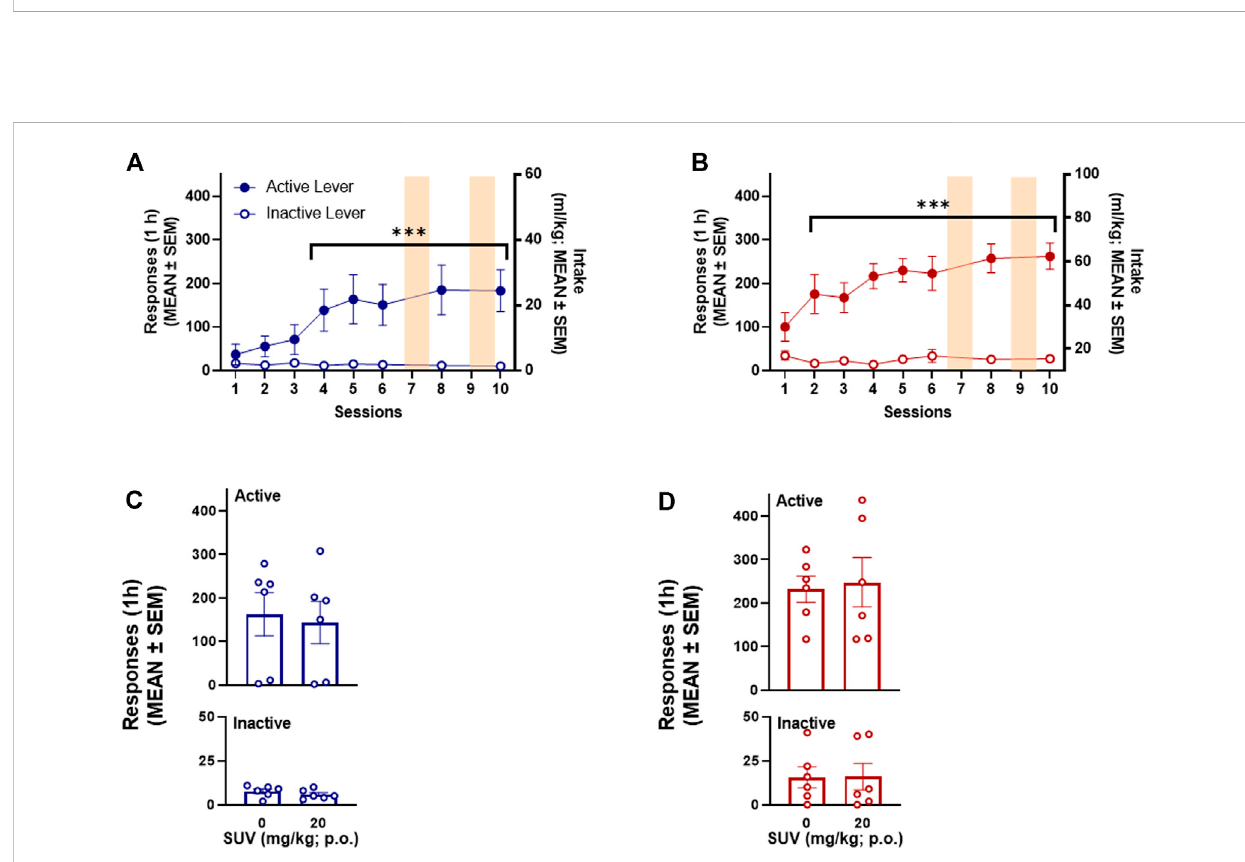
FIGURE 7 Effect ofsuvorexant onSCM-reinforced behavior.SCM self-administration inmales ( n = 6) (A) and females( n = 6) (B) . *** p < 0.001,vs. inactive lever (Dunnett ’ smultiple-comparison posthoc test).Lack ofeffectofSUV onactiveandinactive responsesduring1-hSCM self-administrationinmales( n =6) (C) and females ( n = 6) (D)